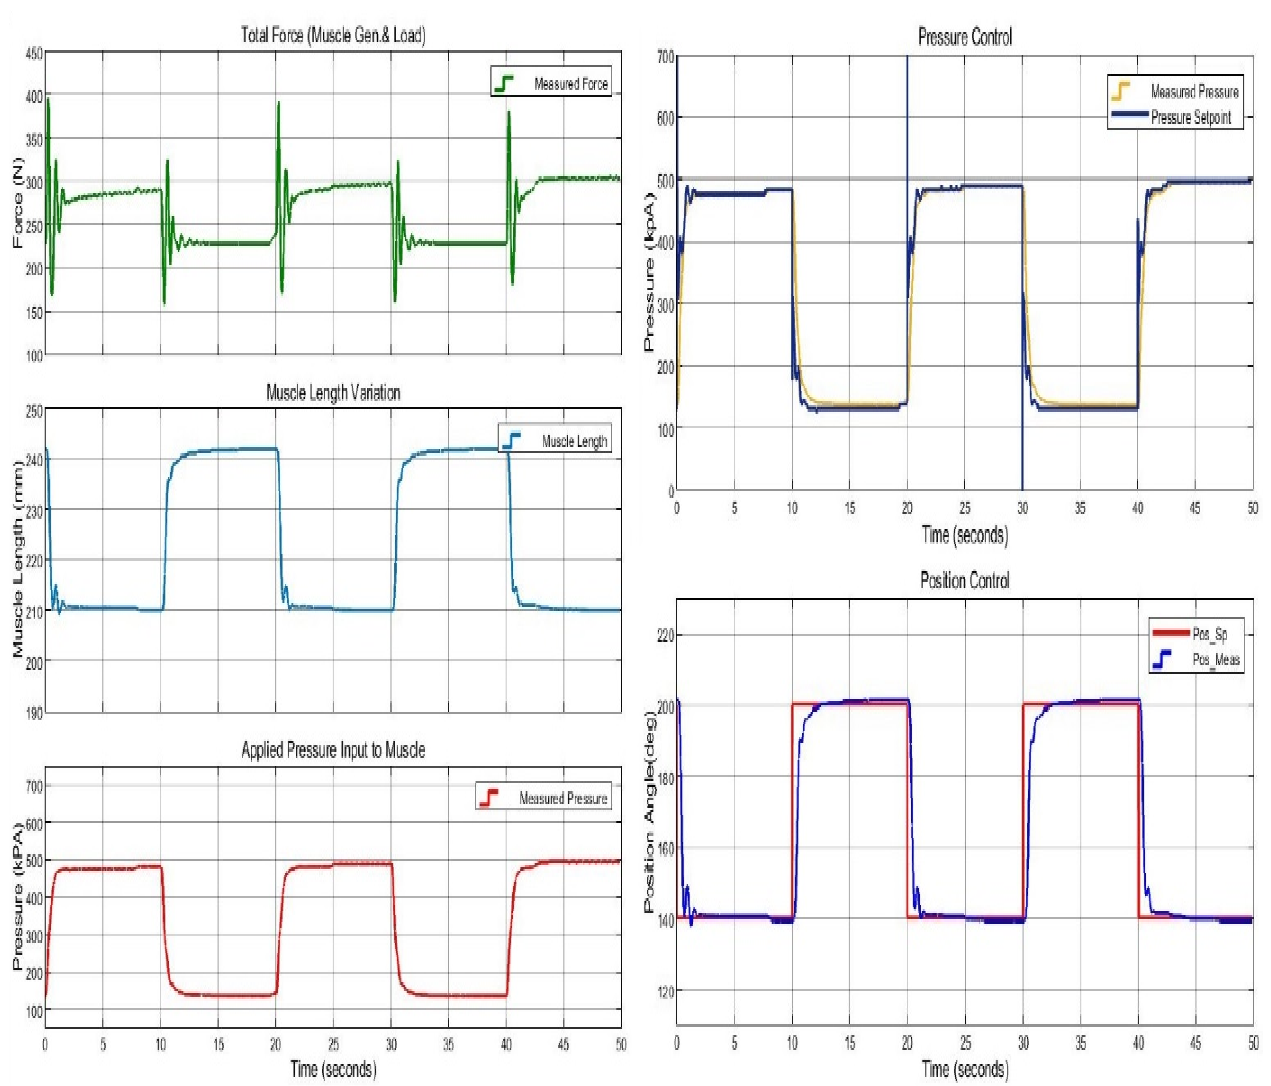
Figure 15. Overview of NARX estimation-based control response at step reference trajectory track- ing operation.